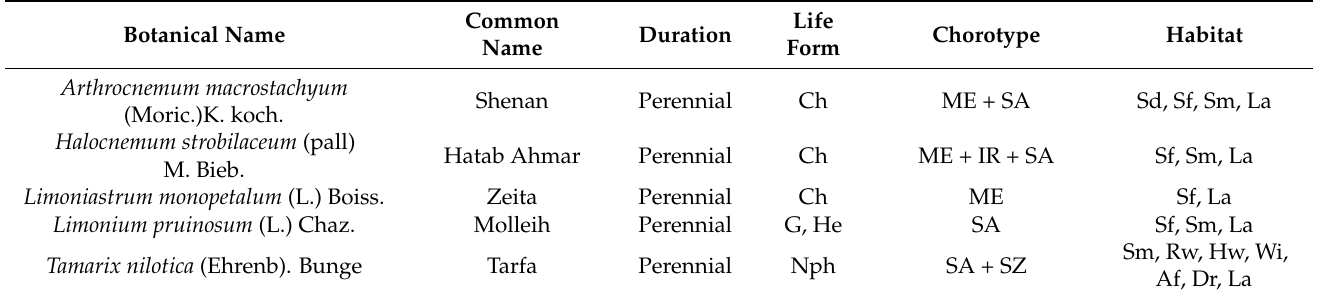
Table 1. Scientific name, life span, life from, chorotype, and habitats of the studied halophytes spe- cies.